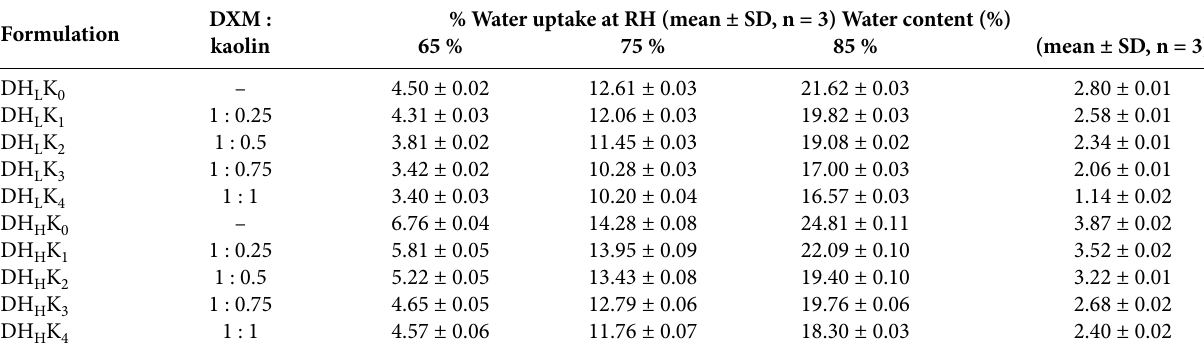
Table 1. Water sorption properties of the film formulations. Formulation